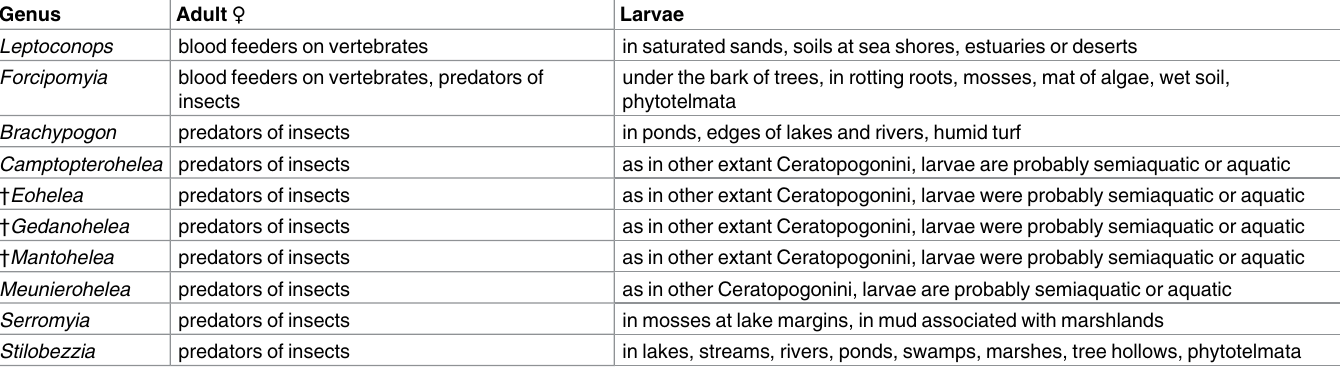
Table 2. Ecology of female adults and larvae of Ceratopogonidae genera found in Cambay amber. Genus Adult ♀